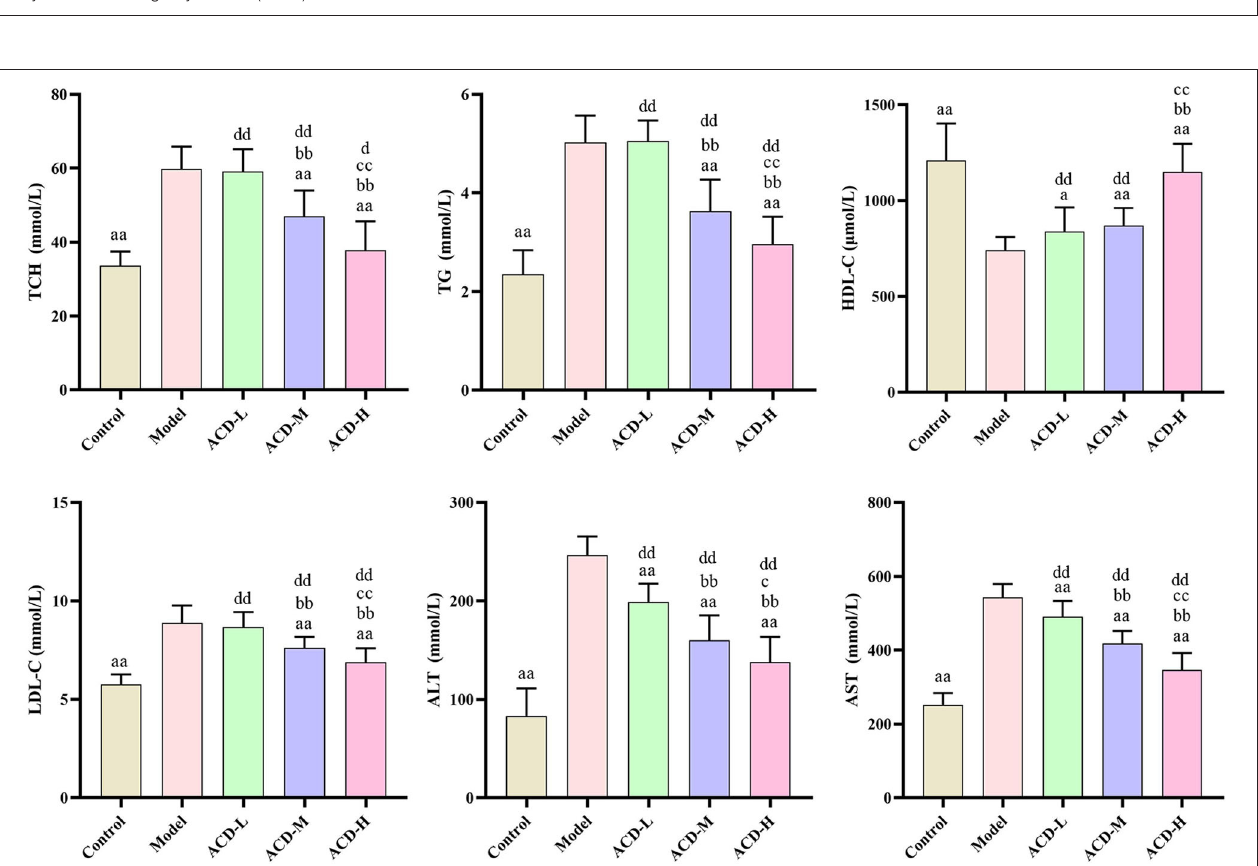
FIGURE 3 | Effects of ACD on biochemical blood indicators in laying hens with FLHS ( n = 8). TCH, total cholesterol; TG, triglycerides; HDL-C, high density lipoprotein cholesterol; LDL-C, low density lipoprotein cholesterol; ALT, alanine aminotransferase; AST, aspartate aminotransferase. a P < 0.05, aa P < 0.01, compared with model group; bb P < 0.01, compared with ACD-L group; c P < 0.05, cc P < 0.01, compared with ACD-M group; d P < 0.05, dd P < 0.01, compared with control group.